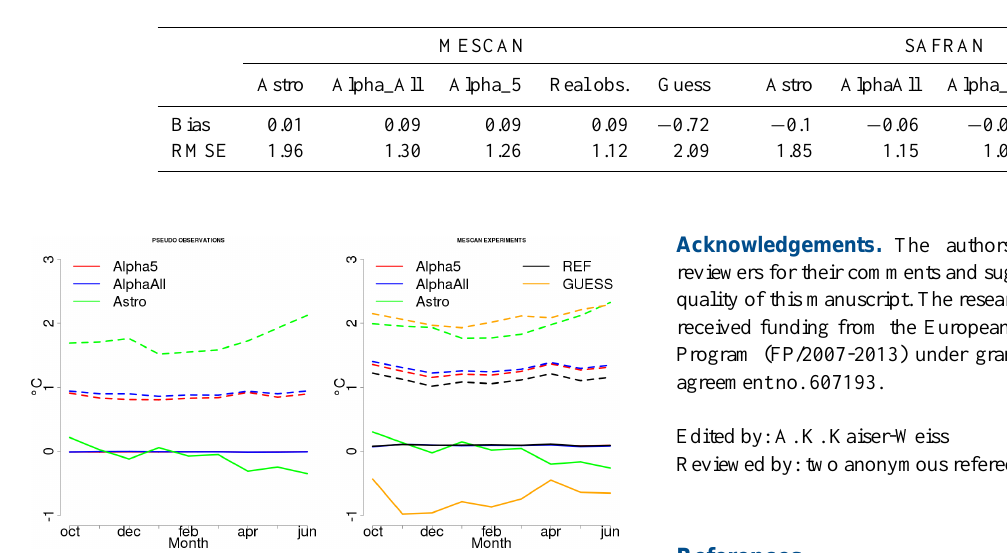
Table 3. Bias and RMSE for MESCAN and SAFRAN (using different data) and MESCAN’s guess at 1555 observation points.